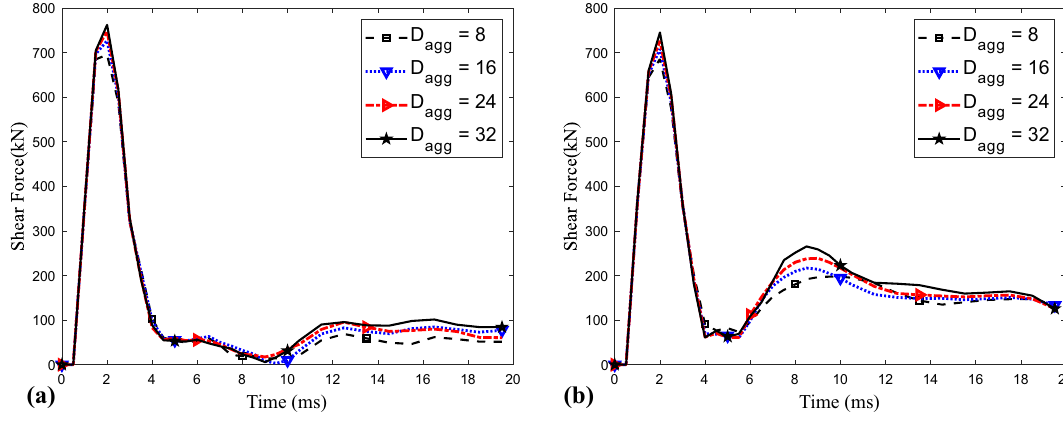
Fig. 20 Critical section shear force–time histories for a BM1-S and b CM1-S